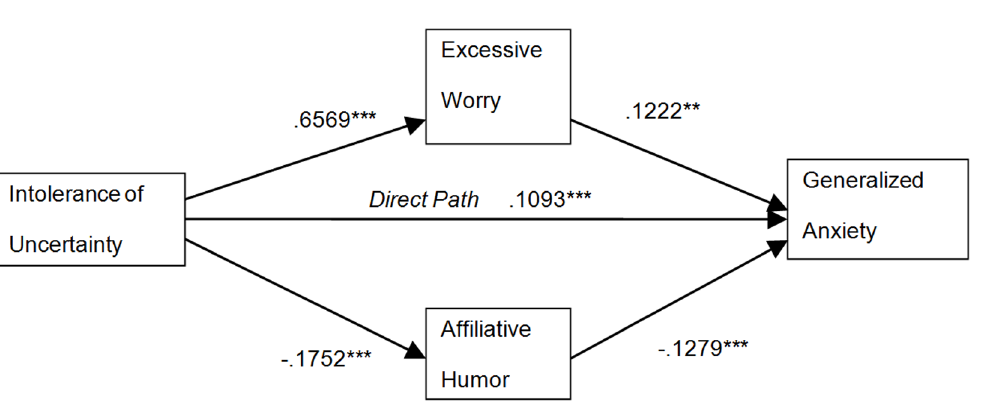
Figure 1. Significant mediators in the combined model for generalized